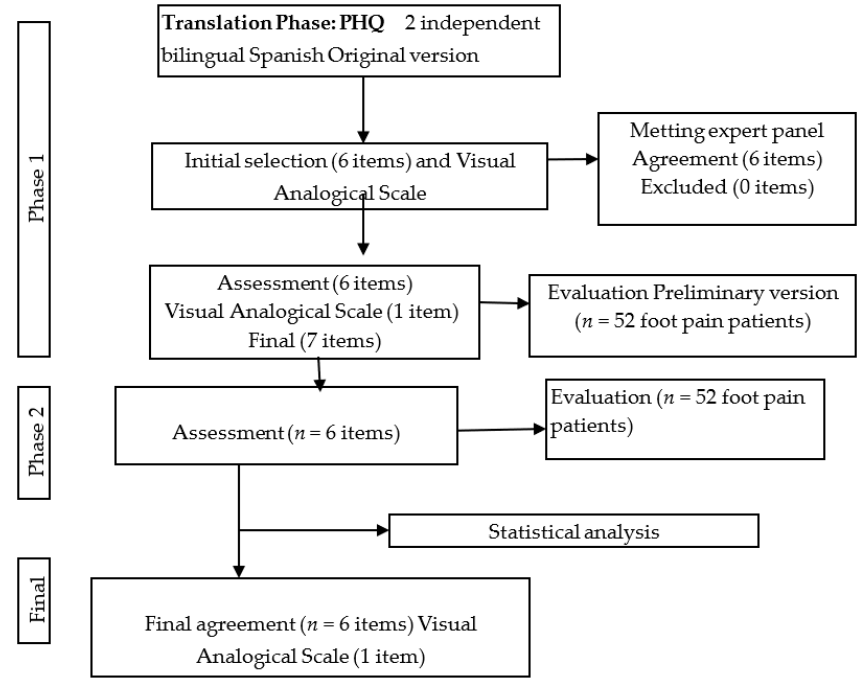
Figure 1. Flow diagram through the research course.